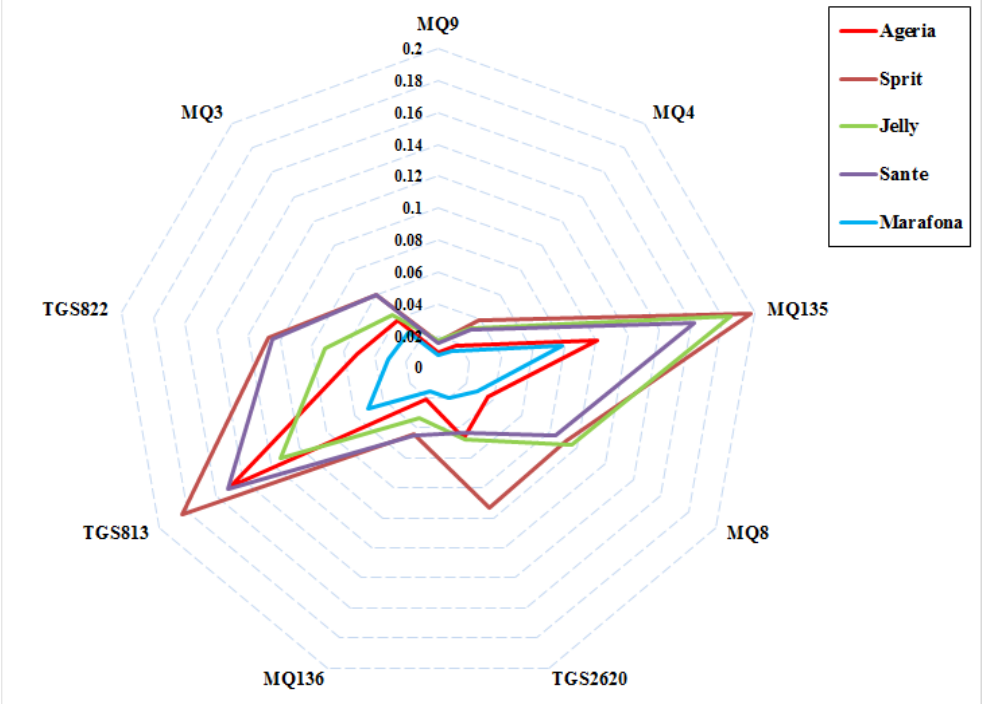
Figure 2. Radar raw fingerprint chart (sensor intensities) of the VOCs potato cultivars. The gas sensors, MOS, TGS813, and MQ135, showed the highest response to sample odor, while the sensors MQ136, MQ4, and MQ9 showed the lowest response.